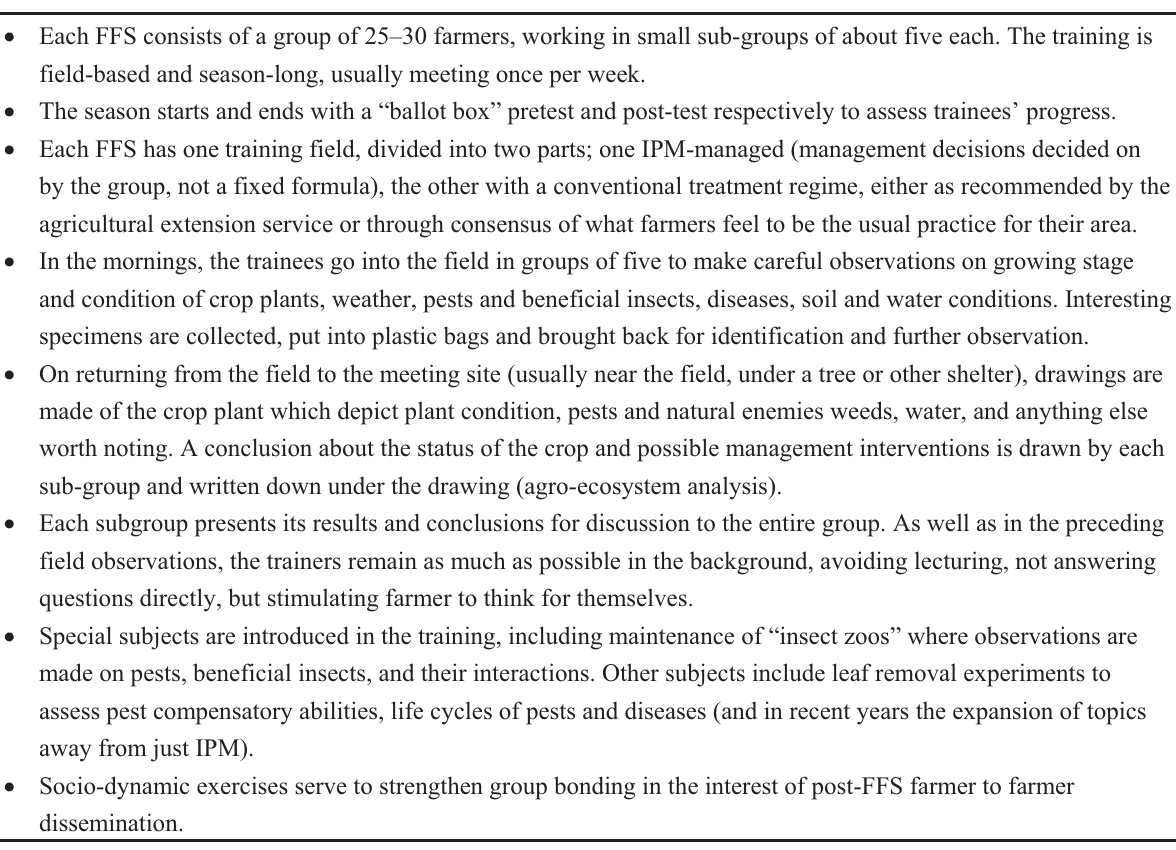
Table 6. The principal elements of farmer field schools (FFS). Source: